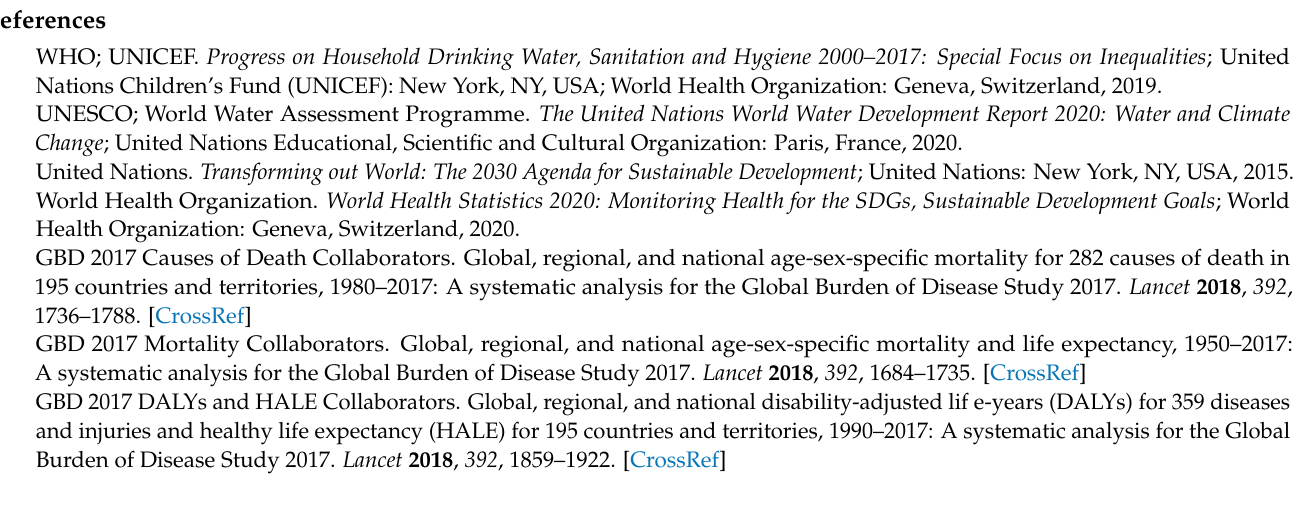
and unimproved water vs. improved and unimproved sanitation. Table S2: Cross tabulation and Spearman correlation of women who have access to improved and unimproved water and sanitation stratified by education. Table S3: Associations between improved (vs. unimproved) water sources and indicators of maternal and child health care services by DHS wealth index. Table S4: Association between improved (vs. unimproved) sanitation facilities and indicators of maternal and child health care services by DHS wealth